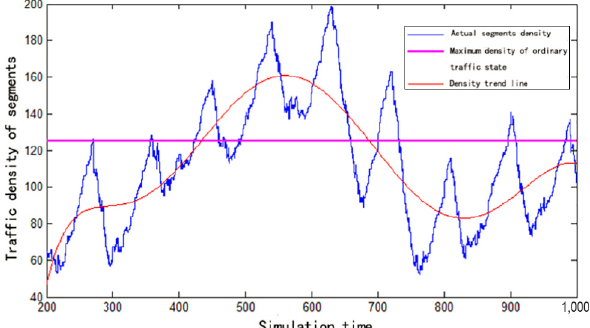
Figure 9 Real-time traf fi c density of segments in fortuitous accidents